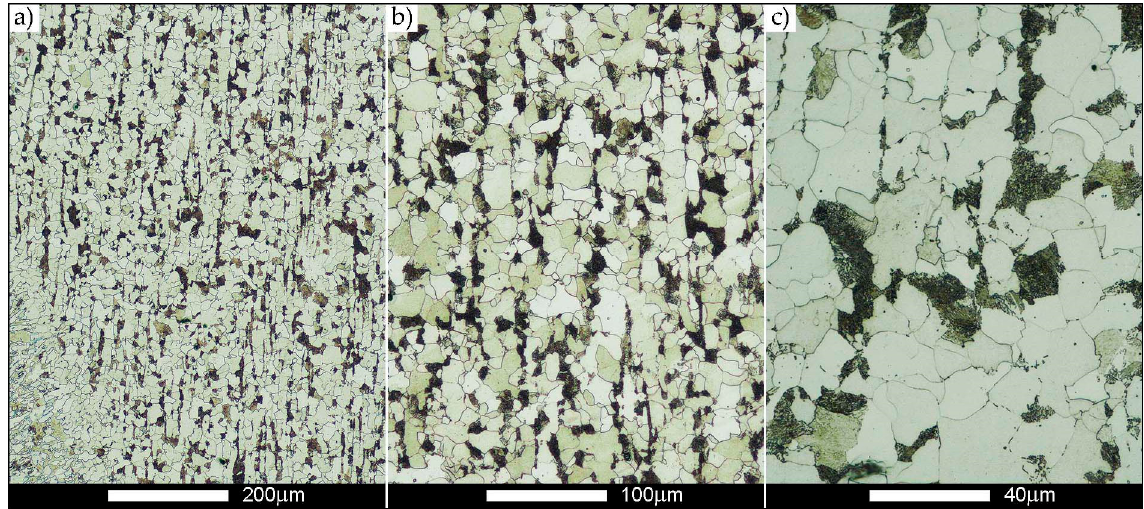
Figure 57. Welded joint microstructure of Hardox 450 in the delivery state (directly after welding) with visible prior austenite grain boundaries—HAZ zone. ( a ) 100×; ( b ) 200×; ( c ) 500×.